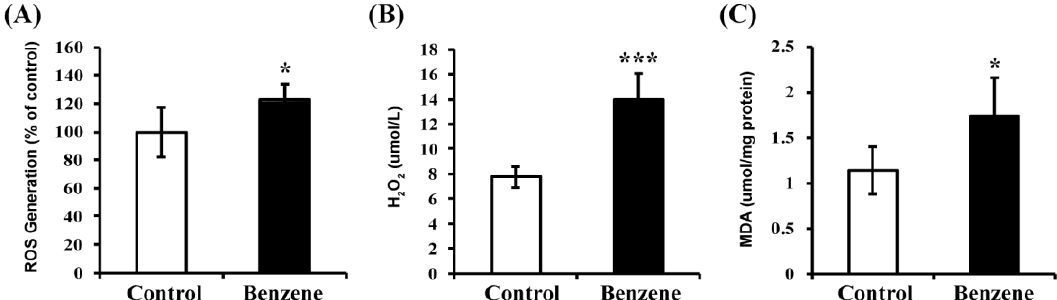
Figure 6. Benzene causes oxidative stress and lipid peroxidation in mouse BM cells. The oxidative stress was evaluated by measuring reactive oxygen species (ROS) production ( A ) and H 2 O 2 level ( B ). The lipid peroxidation was determined by assessing malondialdehyde (MDA) level ( C ). Values are mean ± SD; compared with control group: * p < 0.05; *** p < 0.001.